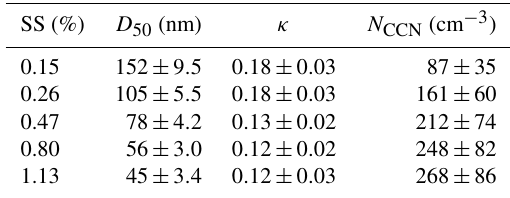
Table 2. Mean derived parameters from CCNc measurements for each set supersaturation (SS), along with ± standard